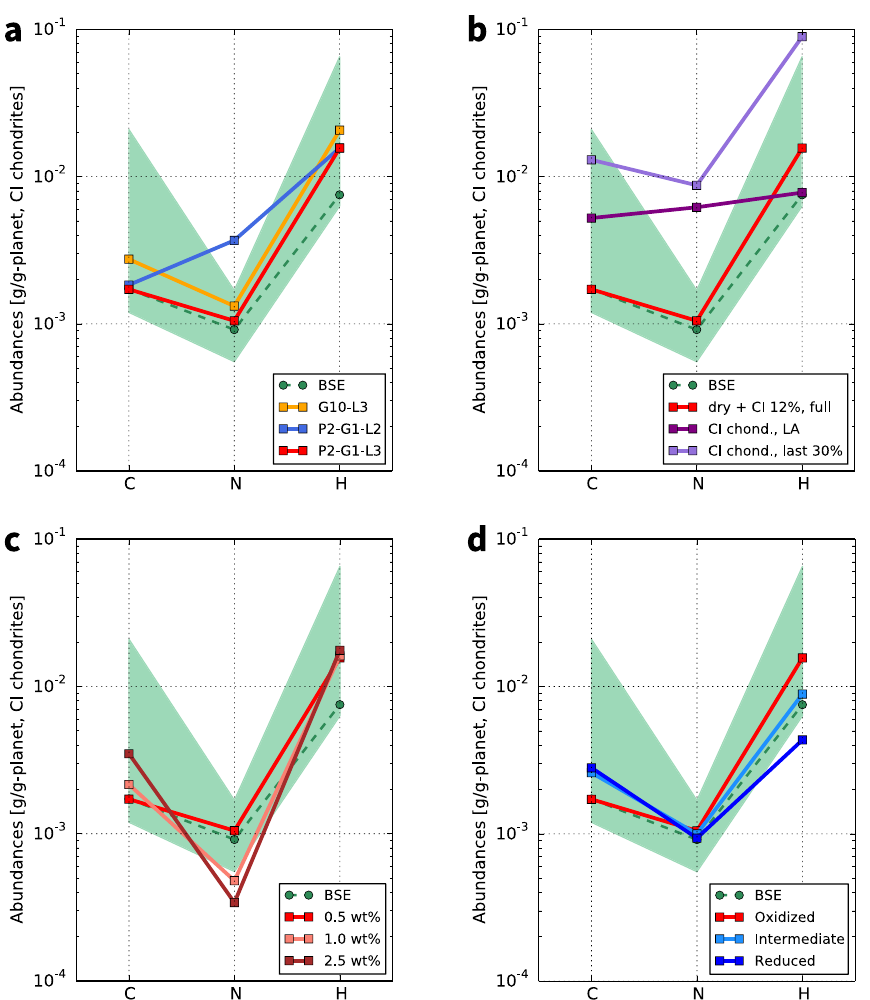
Figure 4. Dependence of final volatile composition of the bulk silicate Earth (BSE) on the accreting conditions. ( a ) Effects of the impactor’s size distribution. P2-G1-L3 (the nominal model, red line): planetesimal accretion ( q = 2 and q = 3 for in the main and late accretion stages, respectively) and one giant impact. G10-L3 (orange line): ten giant impacts and the late accretion of planetesimals . P2-G1-L2 (blue line): shallower planetesimal size distribution ( q = 2 throughout the full accretion) and one giant impact. Here we assumed dN / dD ∝ D where N ( D ) is the number of objects of diameter smaller than D , and q is the power law index. ( b ) Dependence on volatile accretion scenarios. Late volatile accretion (dark-purple): volatiles are delivered only by late accretion with CI chondrite-like bodies. Heterogeneous accretion model (purple): volatiles are supplied in the last 30 wt% accretion with CI chondrite-like bodies. ( c ) Dependence on the late accretion mass. The mass of late accretion was varied from 0.5 wt% (brown) to 2.5 wt% (orange). ( d ) Dependence on the redox state of the magma ocean. Oxidized (the nominal model, red line), intermediate (light blue line), and reduced (blue line) conditions are compared. The solubilities and partitioning coefficients are summarised in Table